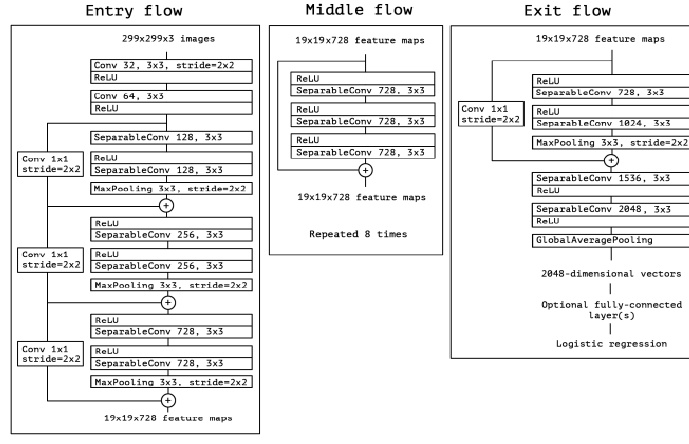
Figure 2. Xception Architecture [20]